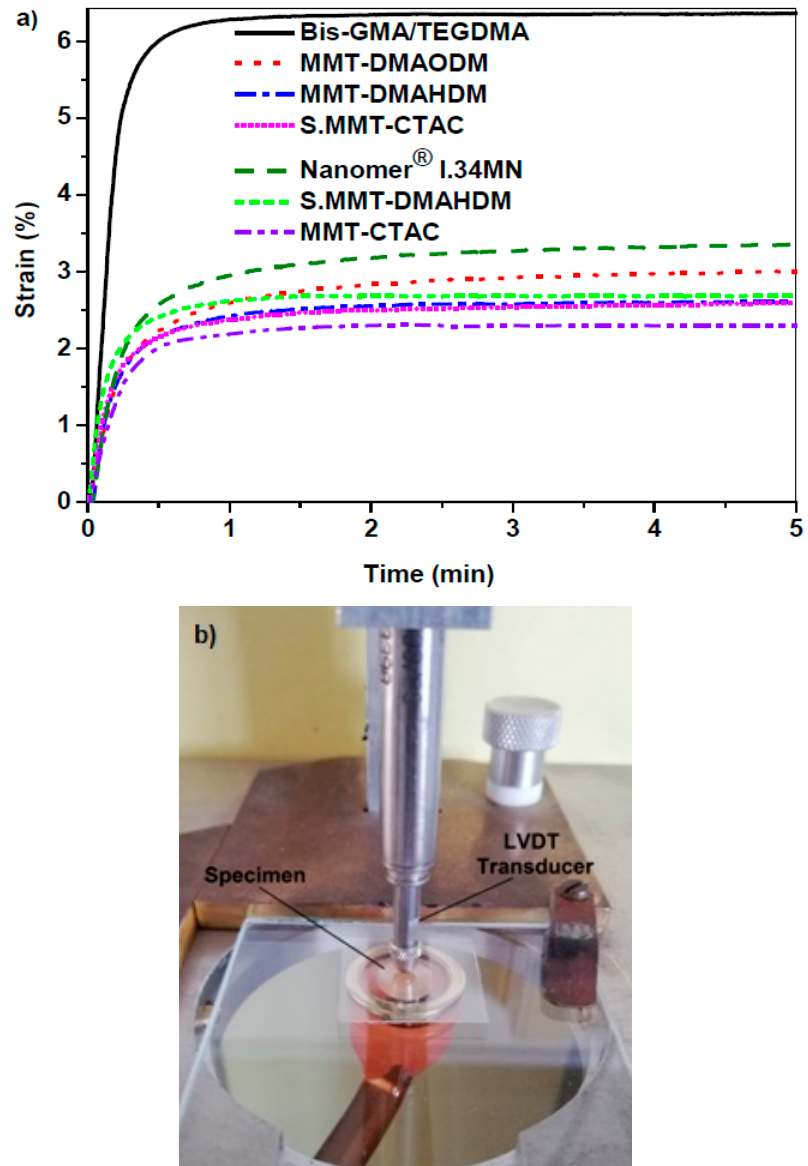
Figure 7. ( a ) Time dependence of polymerization shrinkage strain of Bis-GMA/TEGDMA matrix and dental nanocomposite resins with diverse types of OMMT nanoclays; ( b ) Apparatus utilized for polymerization shrinkage measurements.